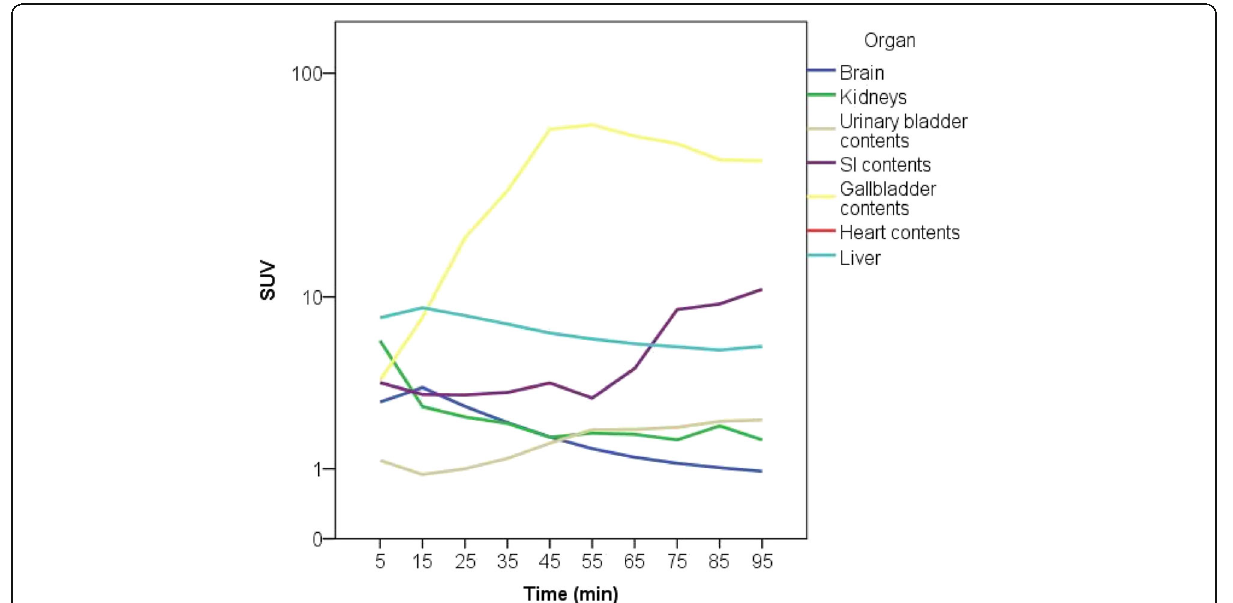
Fig. 3 Typical time – activity curves for selected organs (liver, gallbladder wall, small intestine, brain, kidneys, and urinary bladder after injection of 240.5 MBq [ 18